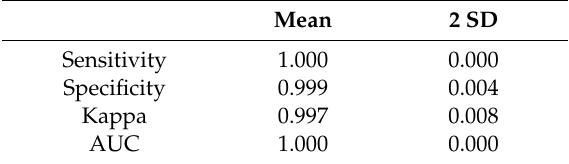
Table 3. Average Neural Network performance evaluation on test